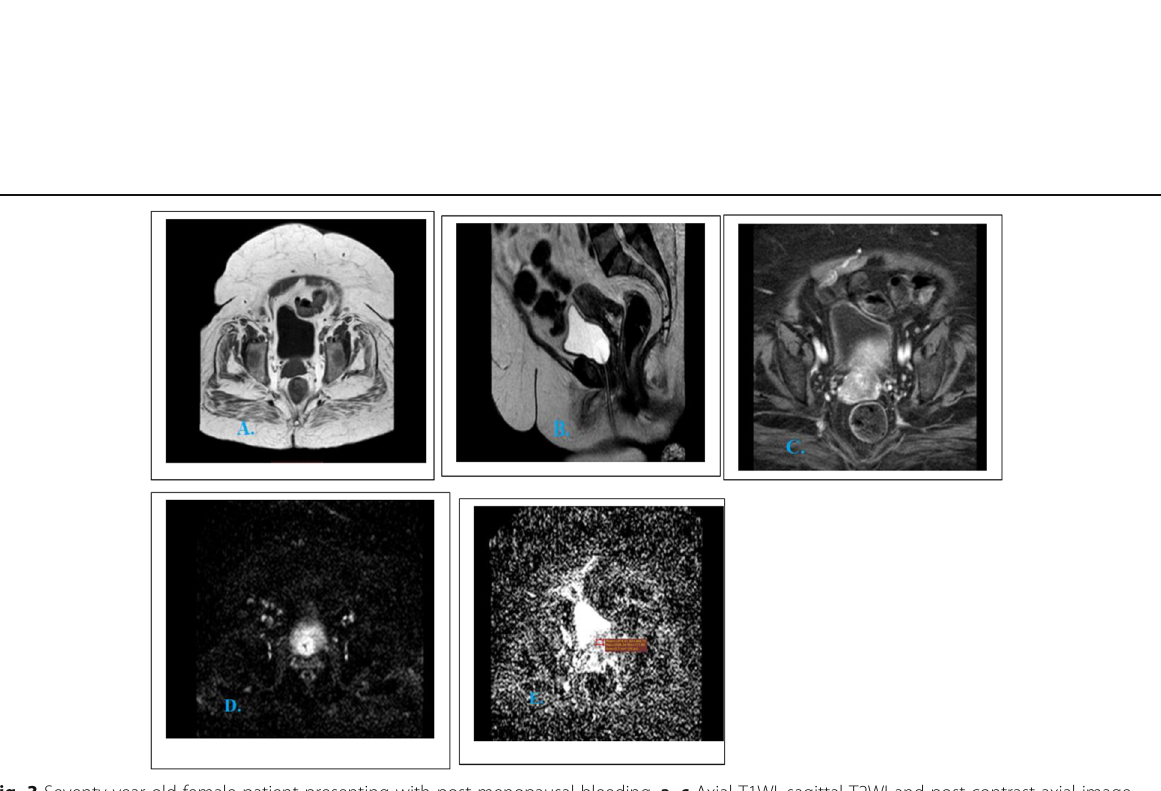
Fig. 2 Fifty-five-year-old female patient complaining of post-menopausal bleeding. a Axial T1WI revealed low signal cervical canal circumferential thickening measuring 3 × 2.7 × 3 cm in (AP, transeverse, CC) dimensions. b Sagittal T2WI showed intermediate signal. c Post-contrast axial image with heterogeneous enhancement. d High signal on DWI and low signal on the corresponding ADC maps ( e ). ADC value was (0.831 × 10 − 3 mm 2 /s). Finding suggestive of malignant lesion. Pathology revealed non-keratinizing squamous cell carcinoma